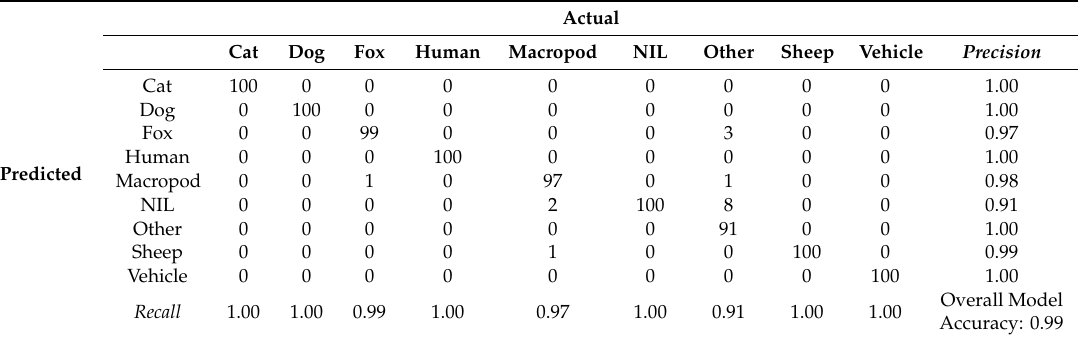
Table 3. Confusion Matrix: New England NSW (natural illumination) model as assessed on a randomly selected hold-out test dataset.